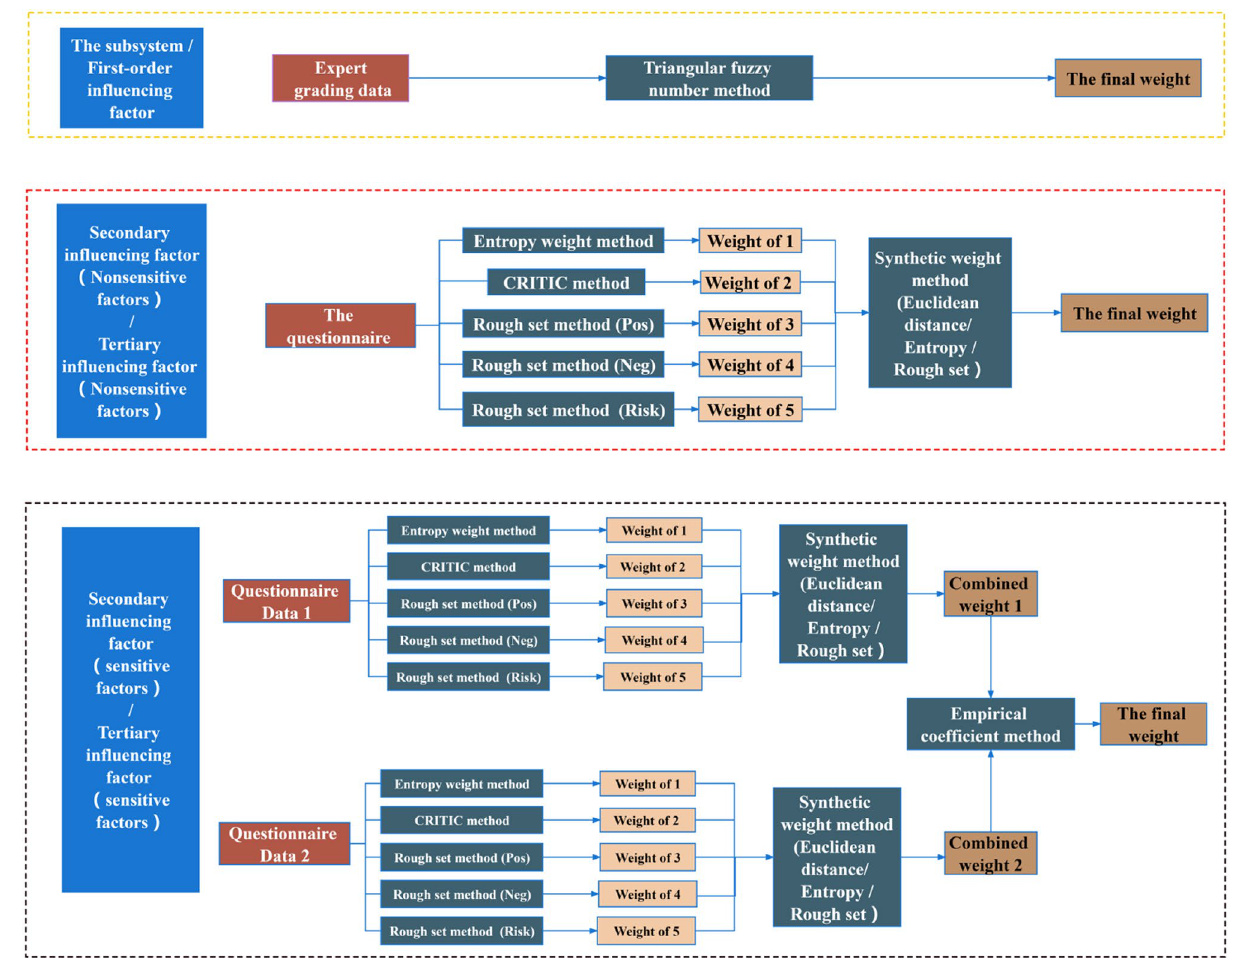
Figure 4. Weight calculation method diagram of indexes at all